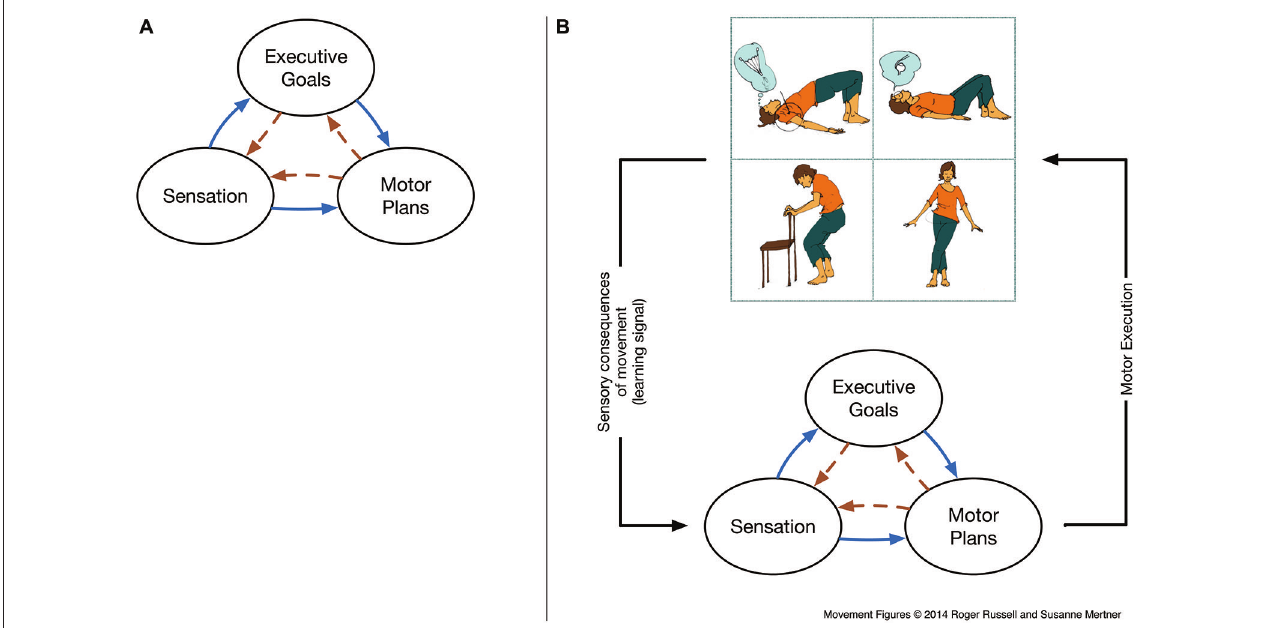
to coordinate and organize between these networks. (B) Embedding sensory, motor and executive functions within the sensorimotor loop. Here, enacting volitional or habitual motor plans continuously generates concrete, immediate and differentiated sensations via the body and world. These signals can be compared with states that are desired (via goals) or predicted (via motor efference). Hence, procedures of skilled coordination of reciprocal mechanisms of inhibition and selection underlying skilled attention and skilled cognitive control can be refined directly within the sensorimotor loop. This yields the profound potential for improvement of selection and inhibition processes, in particular in populations diagnosed with ADHD where impaired motor inhibition/selection is a diagnostic feature. Movement figures reprinted with permission from Russell